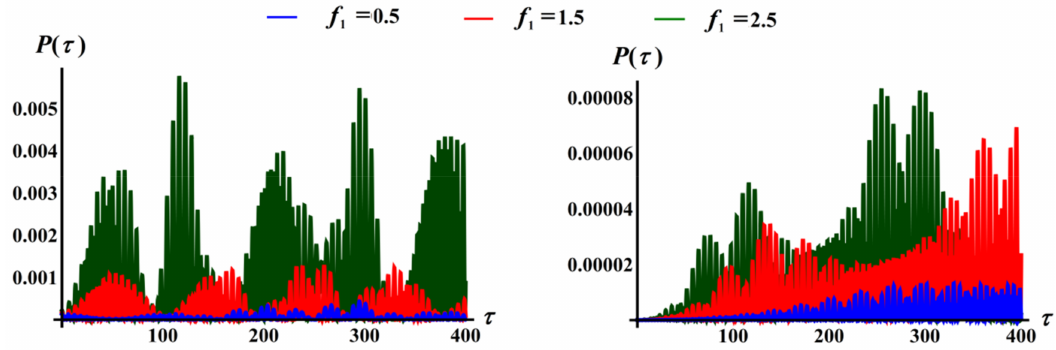
Figure 33. The output power from the two models for different values of excitation amplitudes.